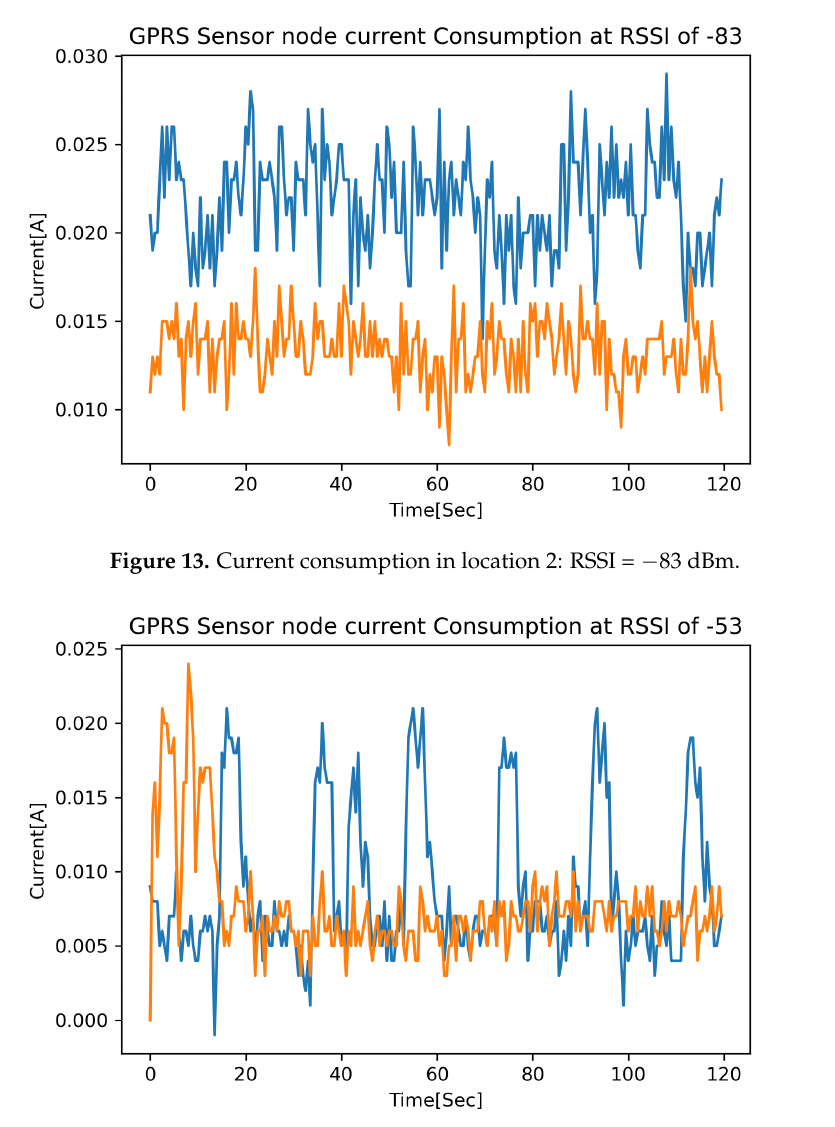
Figure 14. Current consumption in location 3: RSSI = − 53